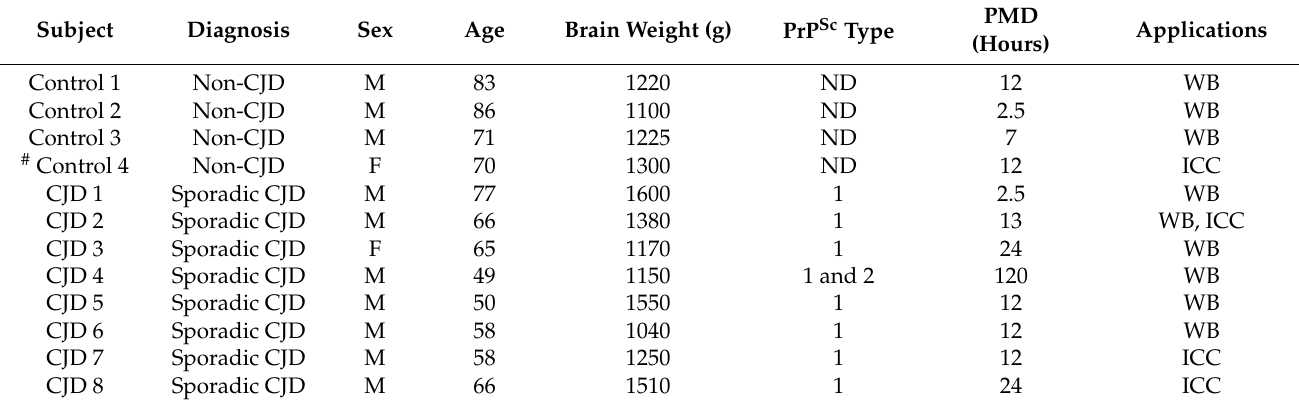
Table 1. Characterization of human